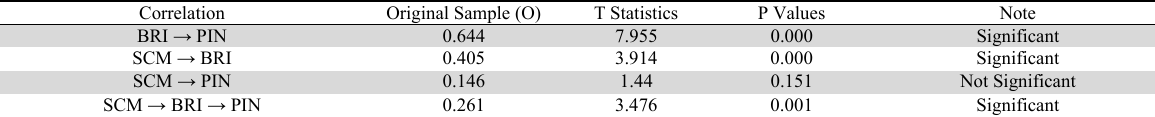
Relationship between Brand Image (BRI) and Purchase Intention